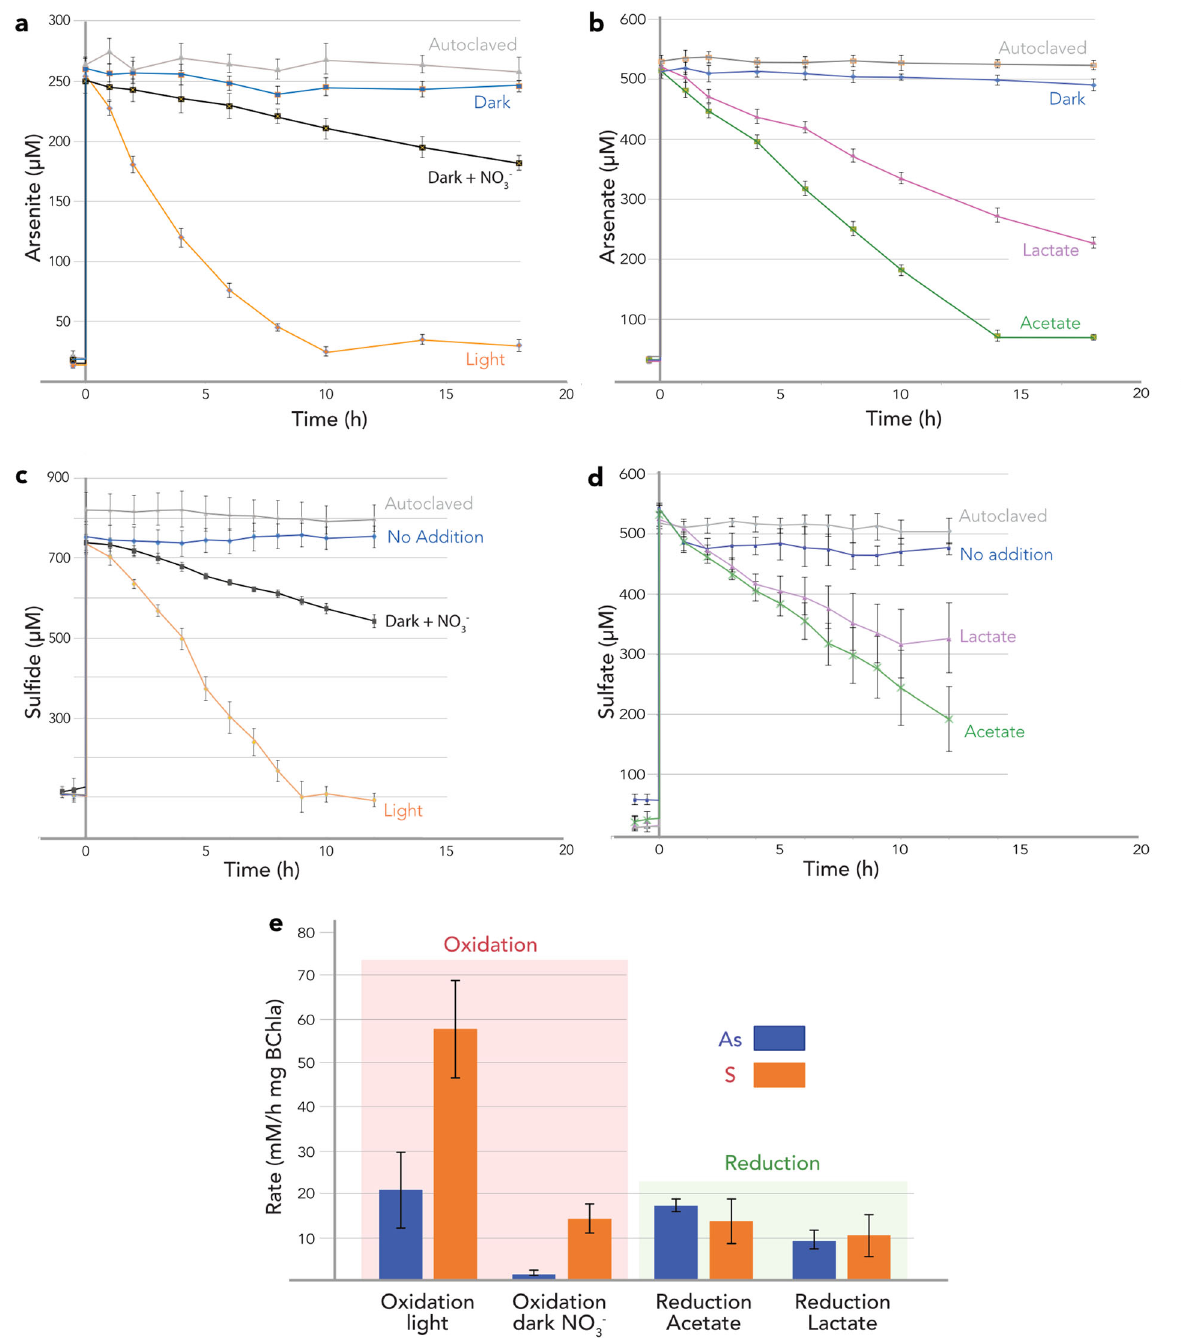
Fig. 3 Arsenic and sulfur turnover in microbial mat homogenates. Arsenic and sulfur consumption in homogenized La Brava mat samples (slurries). a , b time series of arsenic consumption (As additions at t = 0); a As(III) oxidation in various treatments showing rapid consumption of arsenite in the light and no or little change in other treatments; b As(V) reduction in various treatments, indicating rapid consumption in the presence of added acetate and lactate; c , d time series of sulfur consumption (S additions at t = 0); c Sul fi de oxidation in various treatments showing rapid consumption of sul fi de in the light, slower consumption with nitrate and no or little change in other treatments; d Sulfate reduction in various treatments, indicating rapid consumption in the presence of added acetate and lactate; all error bars indicate ±1 SD; e Comparison of maximum potential rates by treatment between arsenic (blue; see a , b ) and sulfur (orange; see c , d ) (see Supplemental Table 1). Pink-shaded rectangle shows oxidation rates, green rectangle indicates reduction The similar potential rates of As(III) and As(V) consumption in La Brava channel mat slurries indicate tight cycling of arsenic, similar to that reported for other elements in microbial mats 12 .